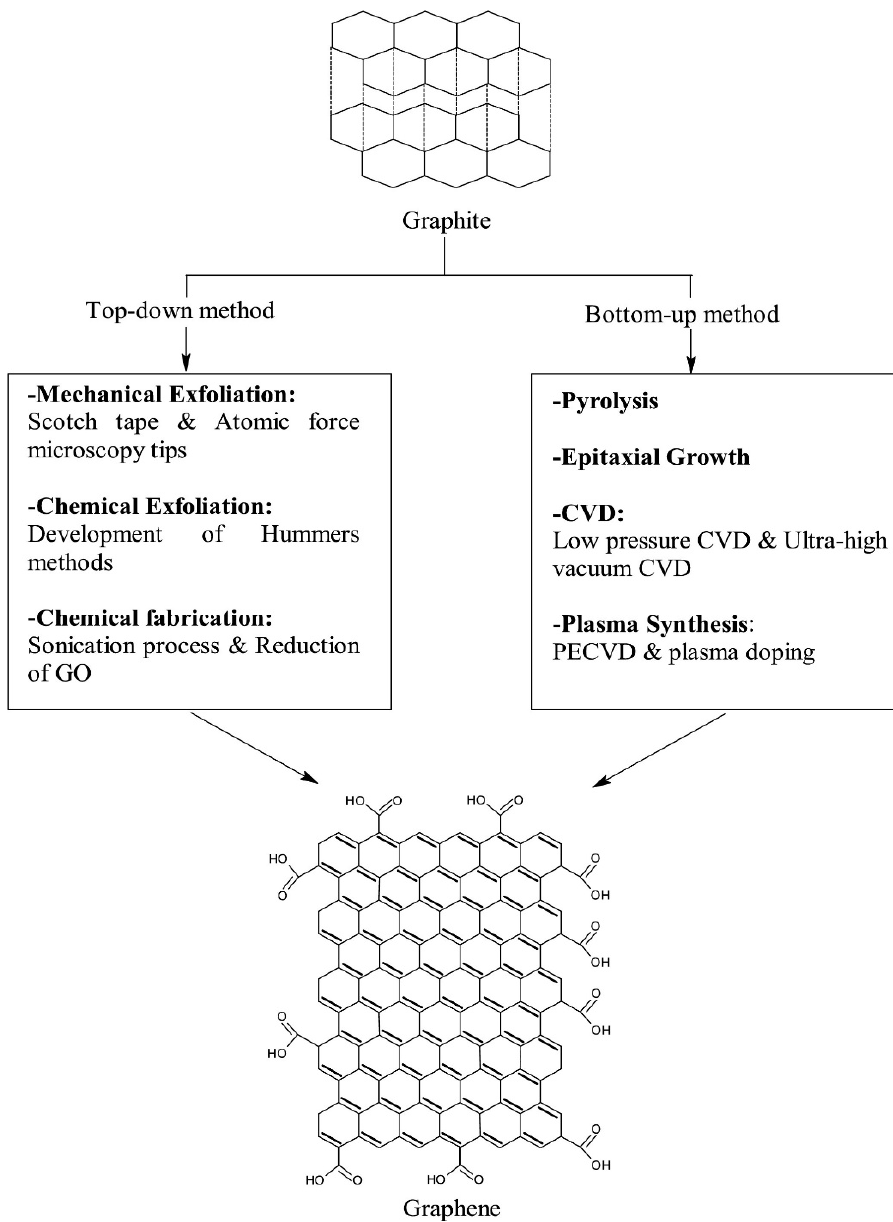
Figure 1. The schematic diagram for the synthesis of graphene. Reprinted with permission from Ref. [30] . Copyright 2018, Elsevier.